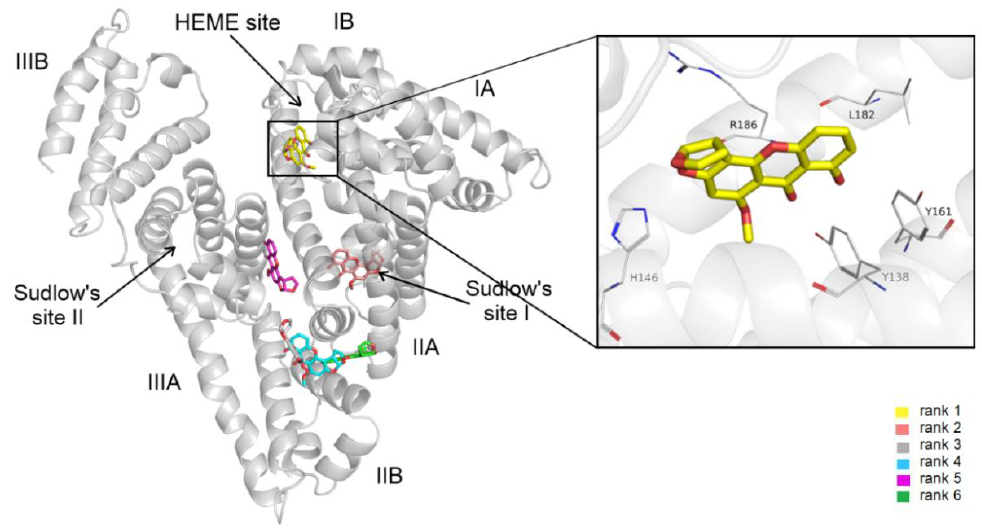
Figure 5. Blind docking results of STC (sticks colored by docking ranks) on HSA (gray cartoon) with the representative binding positions of different ranks (left panel). In the right panel, a close-up of the binding mode in regard to rank 1 is demonstrated, representing the best energy score in the inset with interacting HSA residues (sticks colored by atom types).